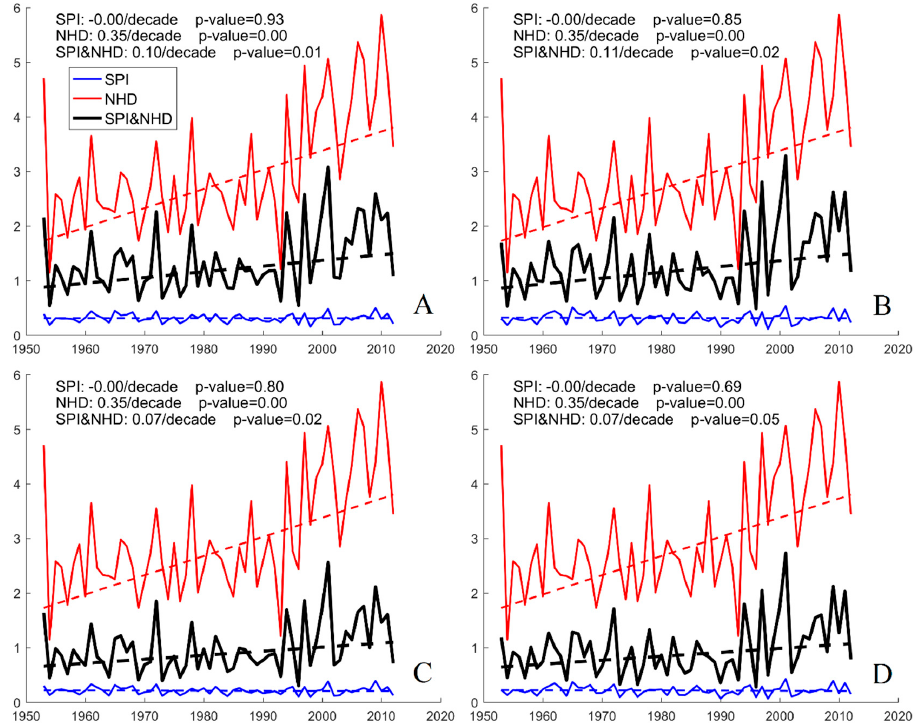
Figure 4. Changes in the spatial extent of drought (SPI), hot extreme (NHD) and compound droughts and hot extremes (SPI&NHD) during 1953–2012 in China based on different time scales and thresholds of SPI. ( A ): SPI3 < –0.5; ( B ): SPI6 < –0.5; ( C ): SPI3 < –0.8; ( D ): SPI6 <